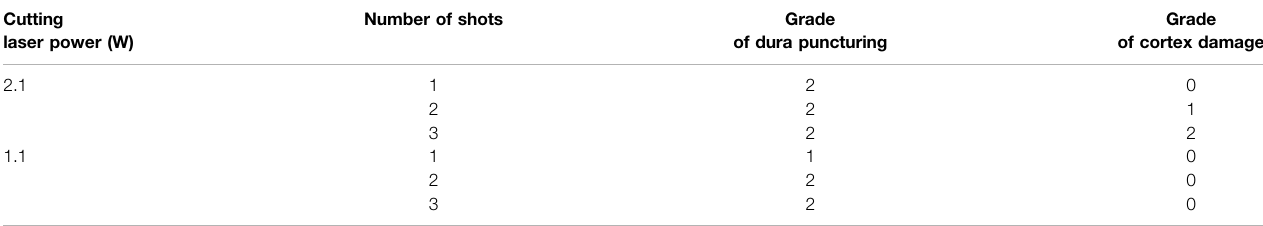
TABLE 1 | Visual assessment of dura puncturing and cortex damage: severity 0 – 2. Cutting laser power (W)